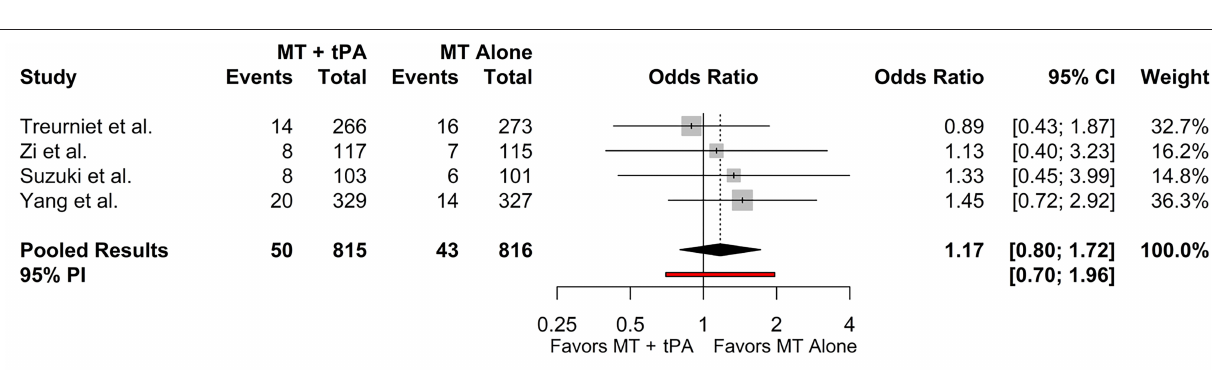
FIGURE 5 | Forest plot of comparisons of sICH. Pooled results were computed via the Mantel-Haenszel method, using restricted effects maximum likelihood for estimation of the between-study variance component and Hartung-Knapp adjustment to calculate a 95% confidence interval (CI) around the pooled effect size. A 95% prediction interval (PI) for the pooled results are also displayed as a red